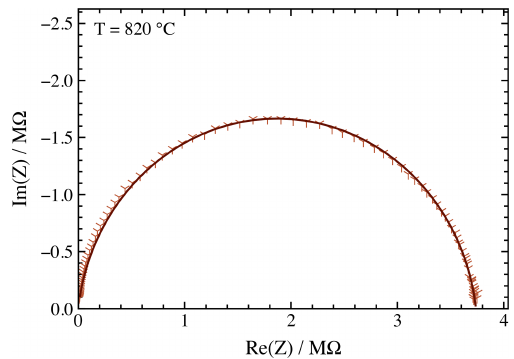
Figure 9. Bode plot of sapphire impedance (points) measured at 820 ◦ C and a fit of equivalent circuit (line) of the data.